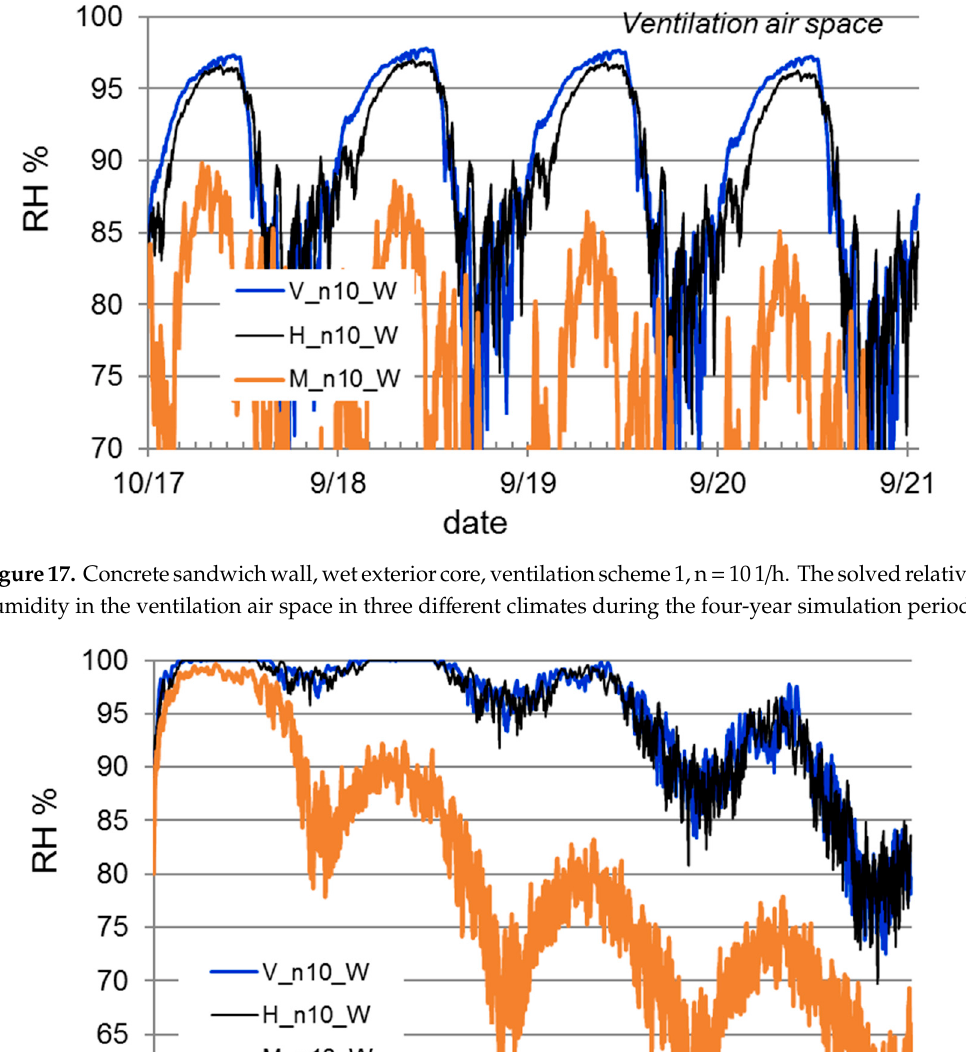
Figure 19. Concrete sandwich wall, wet exterior core, ventilation scheme 1, n = 50 1/h. The relative humidity in the ventilation air space in two climates during the four-year simulation period.